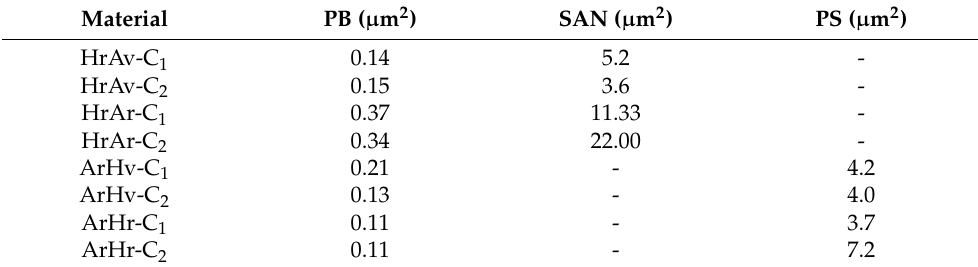
Table 4. Domain sizes of polybutadiene (PB), styrene acrylonitrile (SAN), and polystyrene (PS) phase with different compatibilizers in HIPS/ABS blends. Adapted with permission from ref. [3].